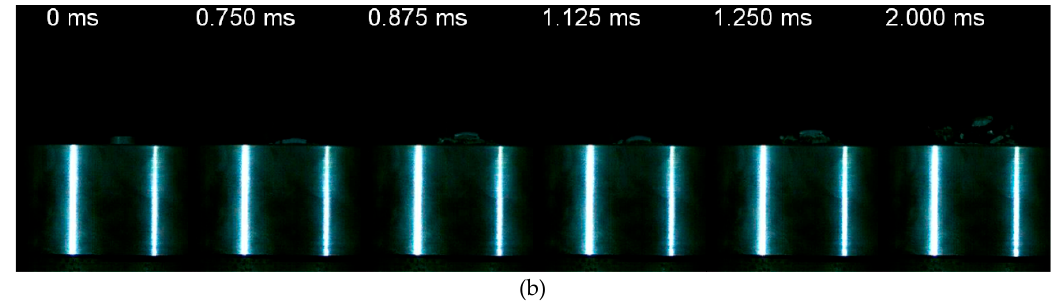
Figure 8. Typical impact response of the PTFE/Al/W reactive materials: ( a ) reacted; ( b ) unreacted.